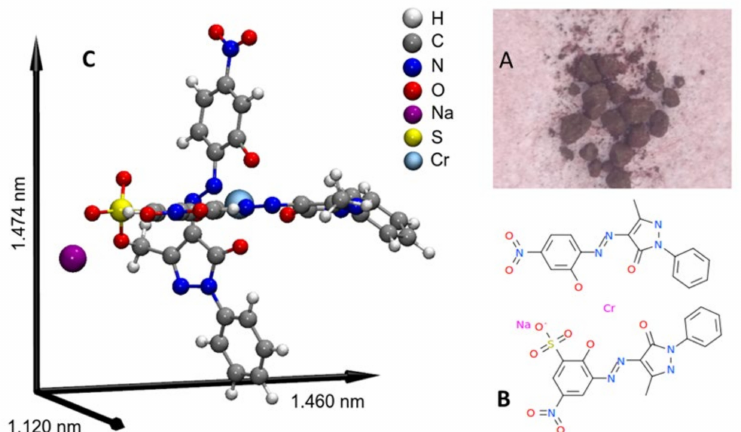
Figure 3. Molecular structure of the Red G dye: ( A ) photo of the dye shown in granular form, ( B ) image of the one-dimensional molecular structure and ( C ) image of the molecular structure dimensioned in